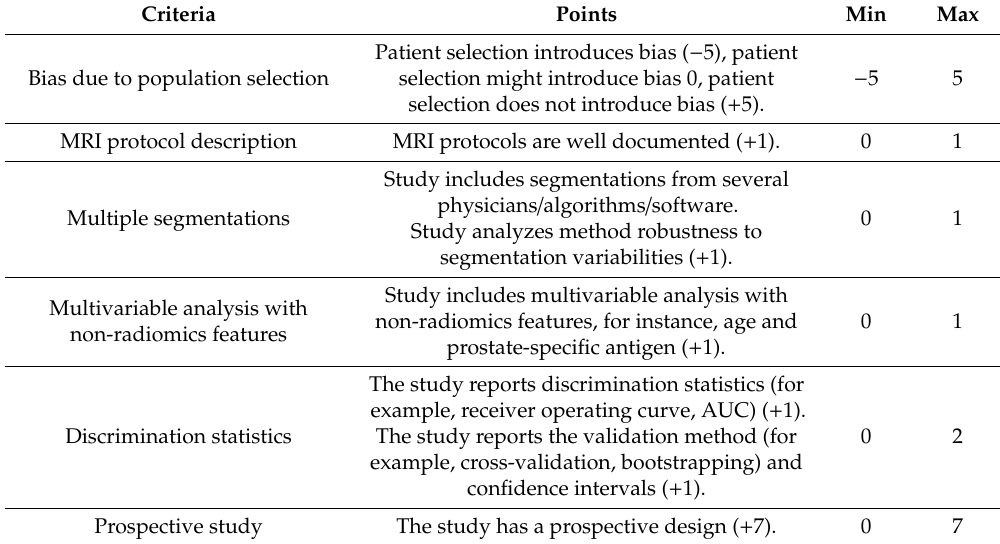
Table 2. Prostate Carcinoma Classification Study Quality Score, modified from radiomics quality score